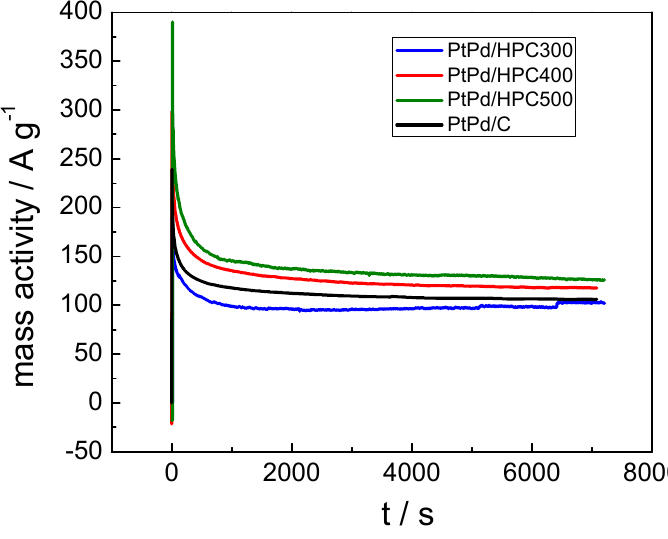
Figure 6. Current transient expressed as mass activity for PtPd/HPC300, PtPd/HPC400, PtPd/HPC500 and commercial catalyst recorded at 0.55 V SO , 25 H 2 4